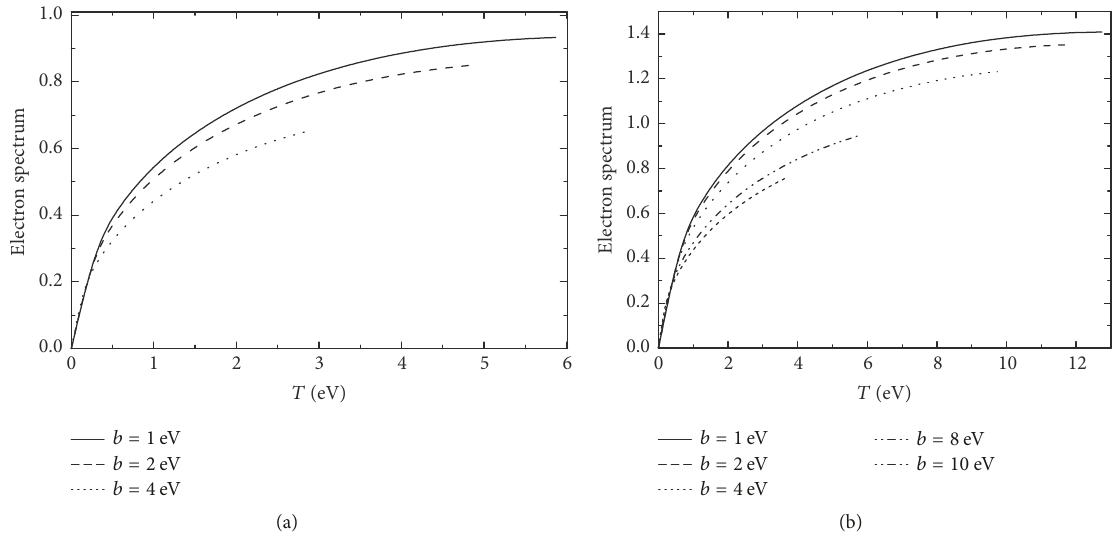
Figure 8: The same as in Figure 7, but for 𝑥 = 50 in panel (a) and 𝑥 = 100 in panel (b). In panel (a) the spectrum is shown for 𝑏 = 1, 2 and 4 eV. In panel (b) the spectra for 𝑏 = 1, 2, 4 and 8eV are shown with 𝑏 increasing downwards.